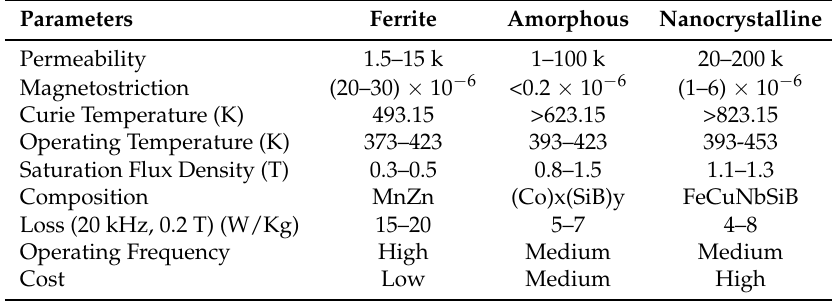
Table 5. Magnetic core material comparison used in